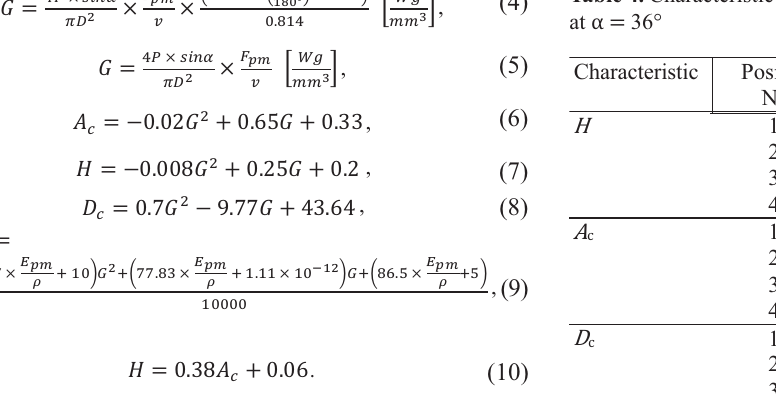
Table 4. Characteristic coefficients in different nozzle